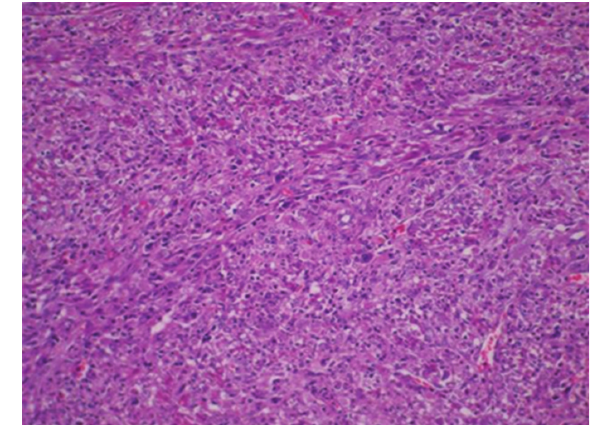
Figure 2: Endoscopic image of the submucosal lesion in the posterior wall of the gastric body.